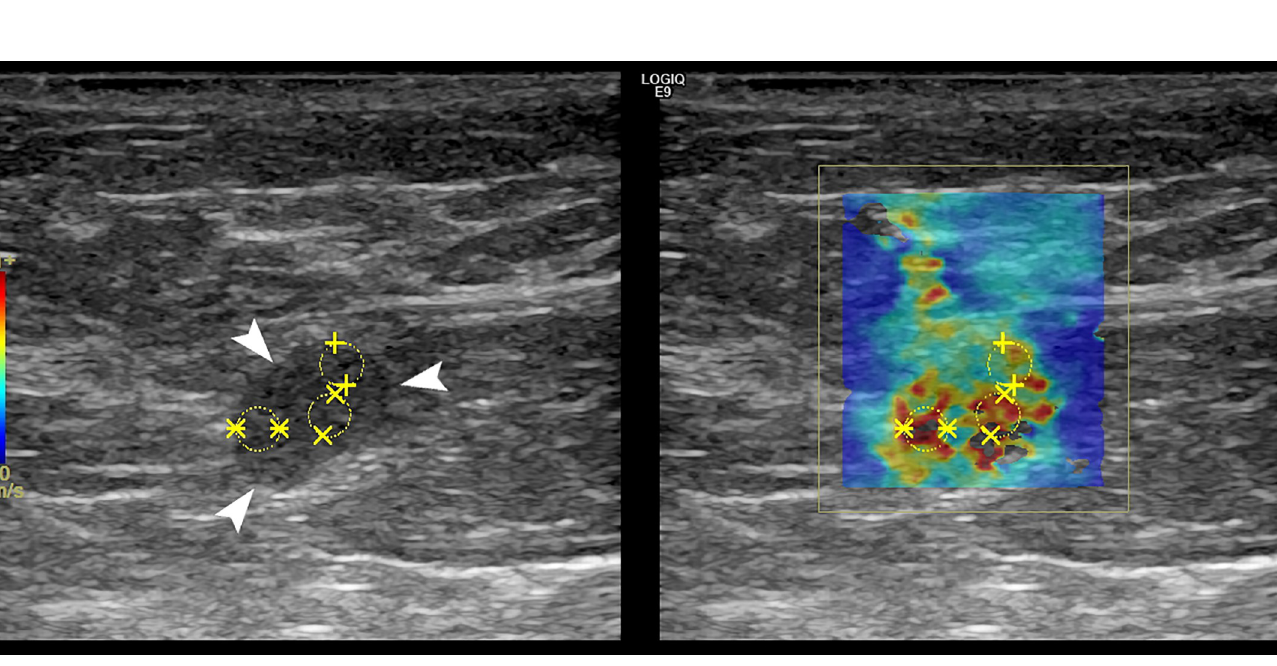
Fig 7. Right axillary B-mode (left) and shear wave speed map (right) images in a 78-year-old woman with a palpable mass in the right breast. The US image shows a level I lymph node (white arrows) demonstrating hilar effacement and cortical thickening (7.2-mm). The elasticity results calculated from the average of the 3 ROIs (yellow) were E mean = 92.7-kPa and E max = 170.1-kPa. FNA biopsy of the axillary lymph node was positive for adenocarcinoma. Right breast core needle biopsy demonstrated invasive ductal carcinoma, grade